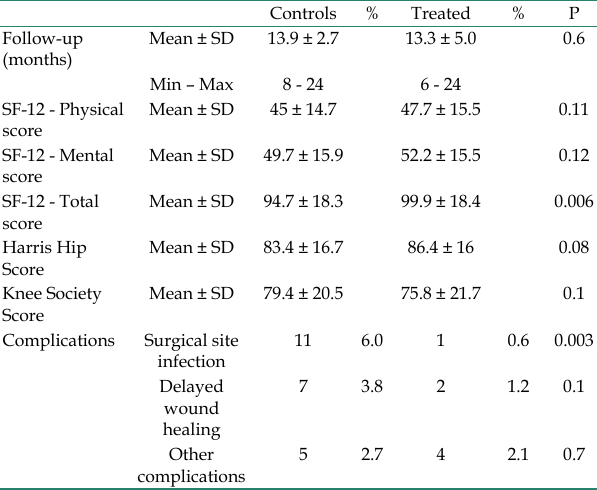
Table 4. Postoperative data at the latest follow-up. Controls %